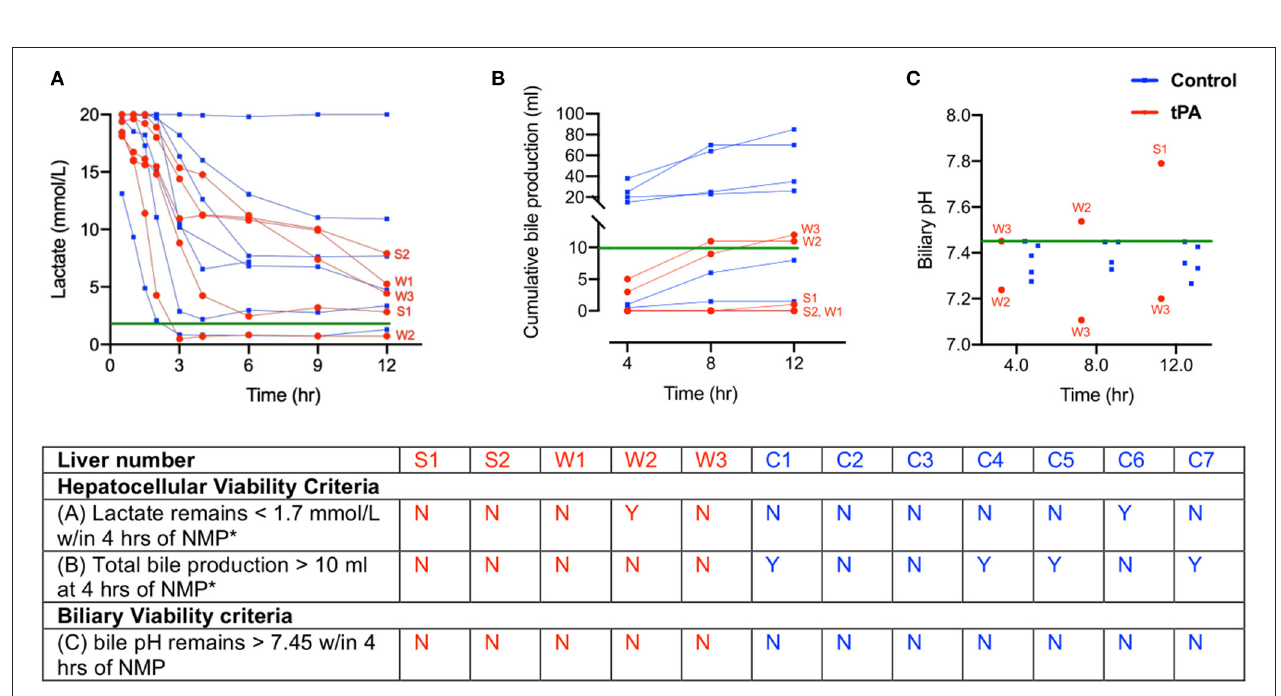
FIGURE 2 | Donor liver assessment during normothermic machine perfusion (NMP) shows all livers are non-viable with both hepatocellular and biliary criteria. (A) Inflow lactate levels (B) cumulative bile production and (C) bile pH in tPA livers (red) and control livers (blue). Green lines indicate viability criteria. Table summarizes hepatocellular and biliary viability criteria for transplantation. *Both hepatocellular viability criteria must hold true for a liver to be viable. tPA, tissue plasminogen activator. W, whole livers with tPA. S, split liver lobe with tPA. C, whole liver controls without tPA. bPH, biliary pH. Y, yes. N, no.